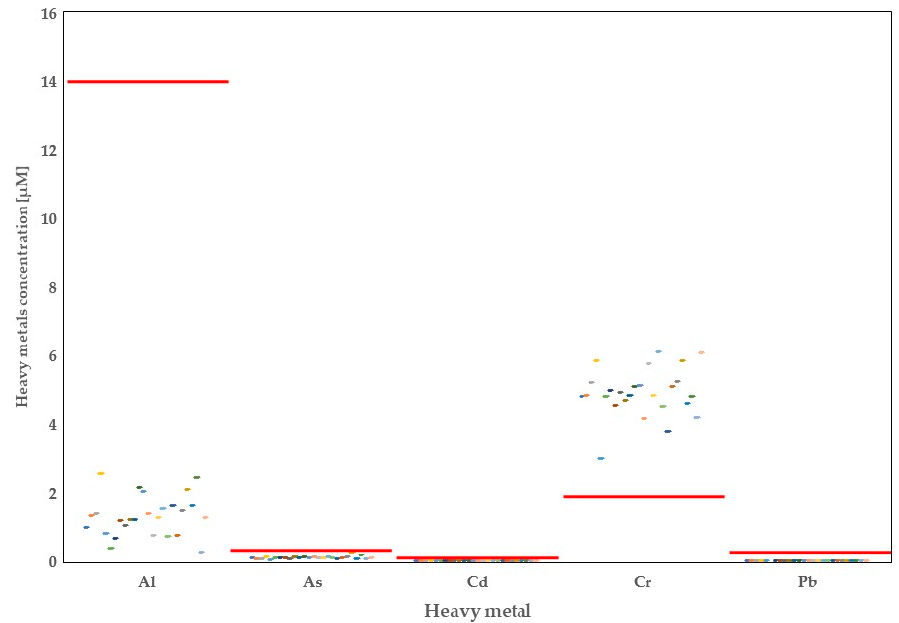
Figure 4. Distribution of heavy metals (aluminium, arsenic, cadmium, chromium, and lead) in Alberta milk samples with regards to world averages (red line).